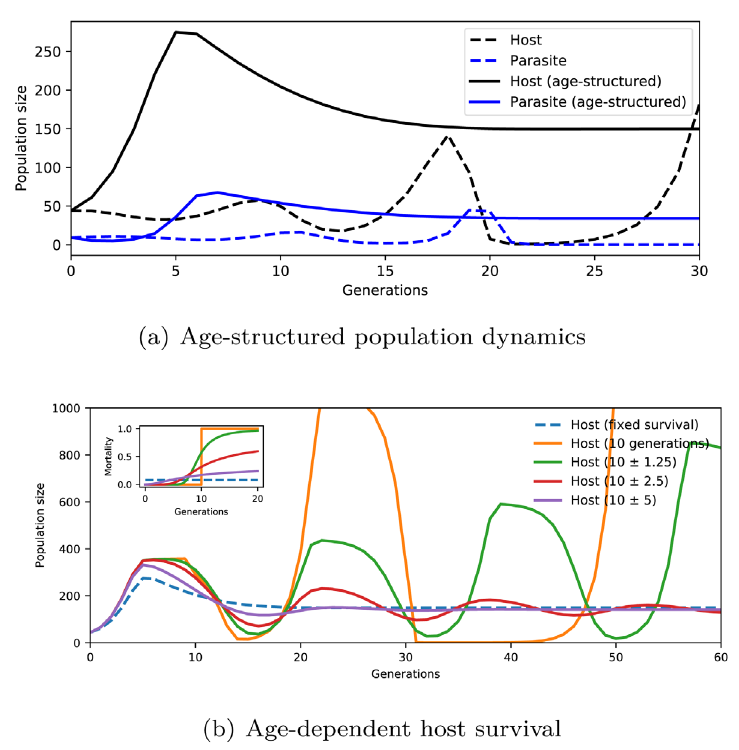
Figure 4. Age-structured host-parasite interactions of Nicholson-Bailey-Hastings. In ( a ), the Nicholson- Bailey model (dashed lines) is compared with its age-structured version (solid lines) where parasites choose host in an age-dependent manner. The number of parasites is scaled down to 25% to aid visualisation. In ( b ), the effect of age-dependent host survival on stability is shown. Mortality rate is given in the inset with respect to age (the number of generations). Dashed line: age-independent mortality; solid orange: life expectancy of precisely 10 generations; solid green, red, and purple: gamma-distributed life expectancy with mean 10 and standard deviation 1.25, 2.5, and 5 generations, age-structured model is able to track the length of the incubation period for each individual and trigger state change only for the right individuals at the right times.